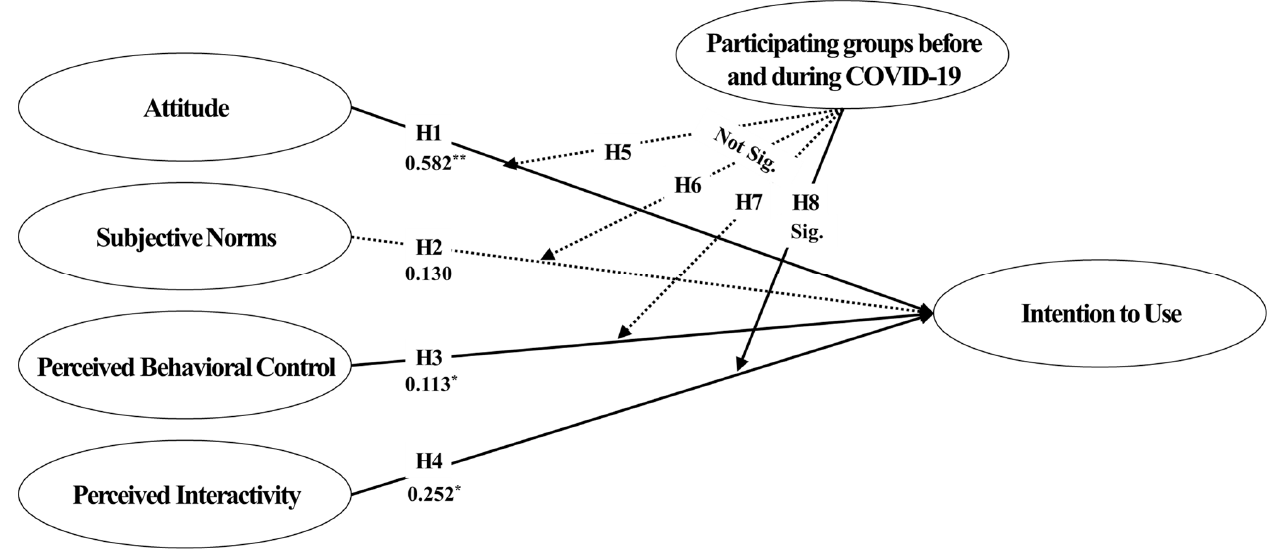
Figure 4. Research model and hypothesis verification results. Notes: *: <0.05 **: